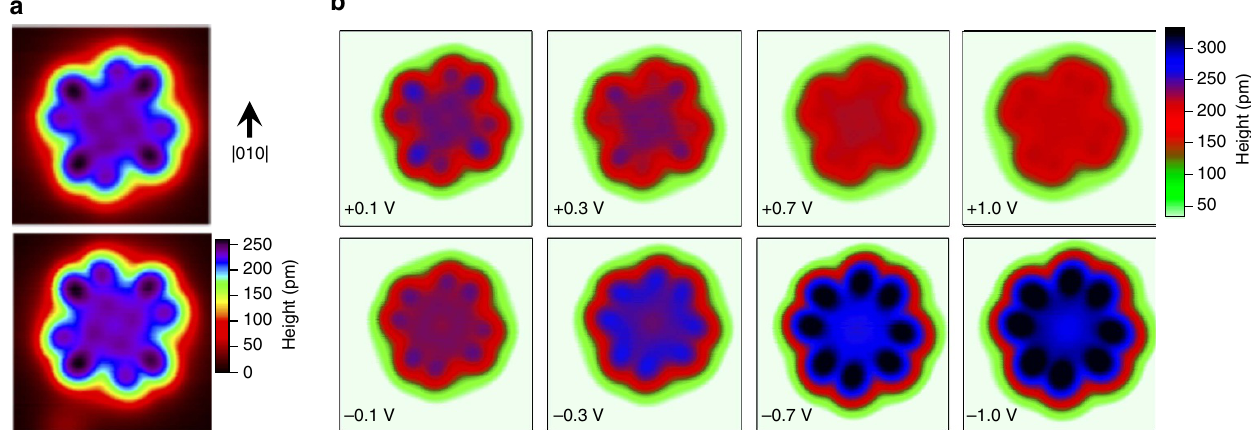
Figure 3 | Electronic asymmetry in images of DyPc 2 . ( a ) Topographic image (4.5 (cid:2) 4.5nm, V set ¼ 0.1V, I set ¼ 0.1nA) of DyPc 2 in two mirror symmetric configurations. A clear asymmetry is observed, which obeys the same mirror symmetry as the underlying binding. This suggests that it is related to the relative orientation of the fourfold symmetric molecule on the fourfold symmetric surface. ( b ) Topographic images (4.5 (cid:2) 4.5nm, I set ¼ 0.1nA) of DyPc 2 on Cu(001) at various bias voltages. The ligand state of the top Pc ring is observed at (cid:3) 0.7V (ref. 14). For small-positive biases, a clear asymmetry can be seen in the ligands that persists at larger-positive voltages but is absent at negative voltages.